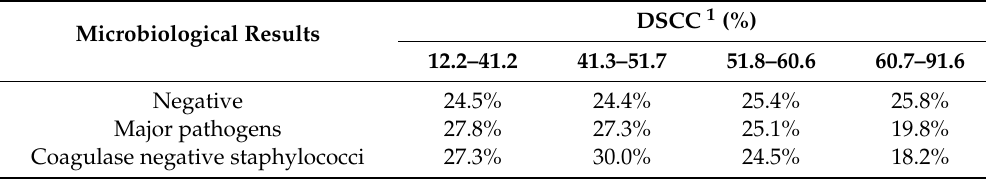
Table 5. Distribution of the microbiological results within the DSCC quartiles.